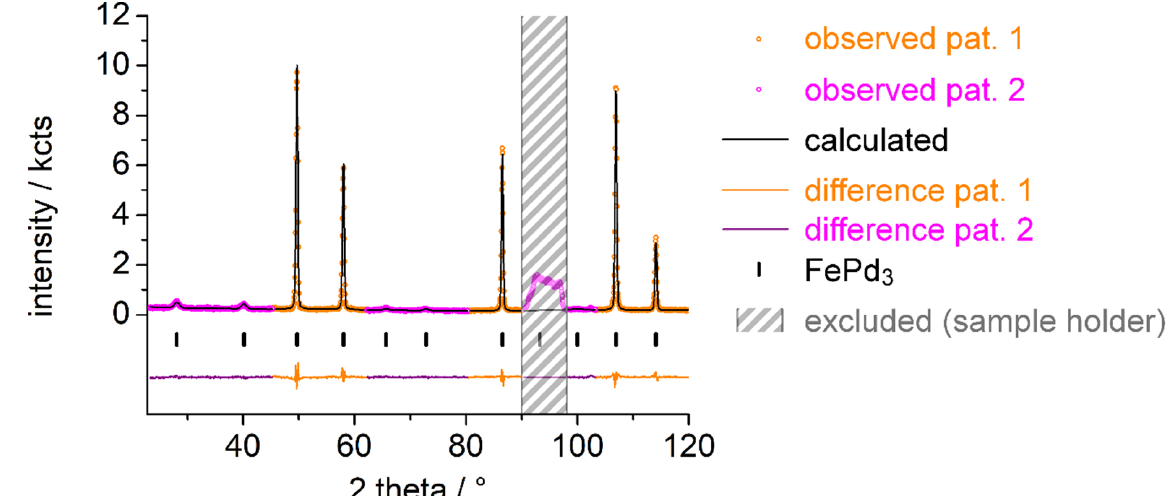
Figure A12. Rietveld refinement of the crystal structure of FePd 3 D 0.027(8) (for details, see fifth row in Tables A6 and A7) based on neutron powder diffraction data (NUMOR 131717 [21], λ =186.80(2) pm, D20 ILL, Grenoble) in a single-crystal sapphire cell at 296(1) K and 4.00(1 ) MPa deuterium pressure using FullProf [24].